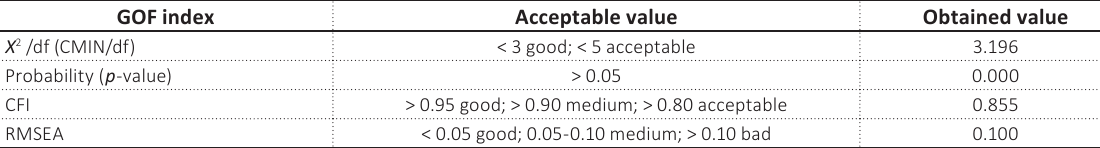
Table 5. Confirmatory factor analysis goodness of fit statistics